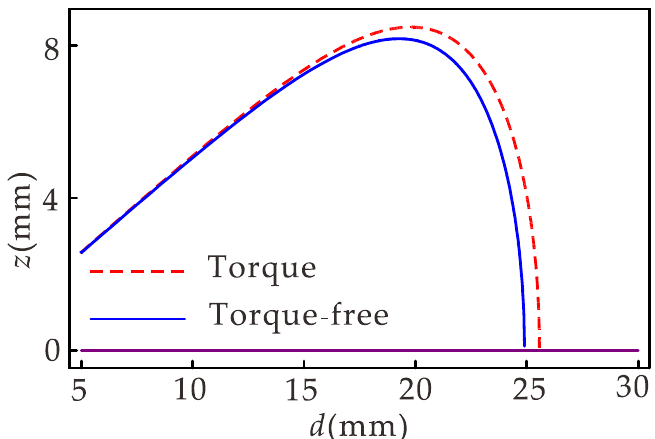
Figure 5. Equilibrium point bifurcation diagram. Figure 6a gives the RMS voltage versus load resistance for the harvester. The RMS voltage increases as the load resistance increases and eventually increases to saturation. Figure 6b shows the corresponding power versus load resistance, where the power first increases and then decreases with the increasing load resistance. It can be observed from Figure 6 that torque affects voltage and power. Figure 7 shows the relationship between the relative error of the output power and the load resistance without considering the torque. The results show that when the load resistance is small and the distance between permanent magnets is large, not considering that the torque causes a large error, and the maximum error can reach 18.96% when d = 24 mm.